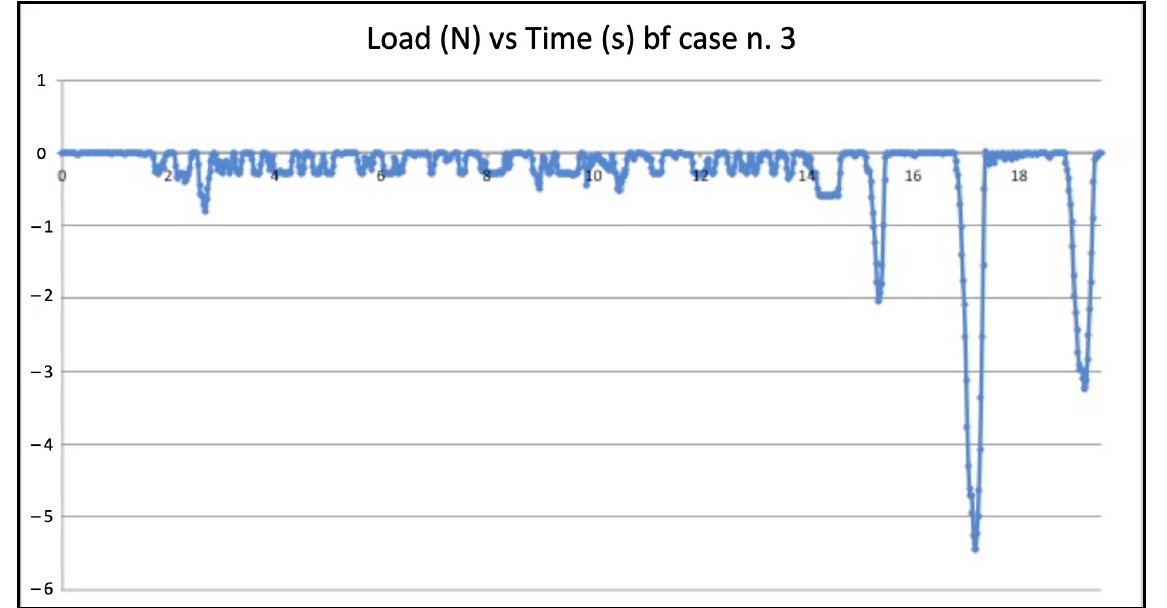
Figure 6. Graphic plot of the simulation on model n. 3 (successfully balanced force technique negotiation). Seven failed negotiations occurred in Group B (tooth n. 2, n. 5, n. 9, n. 14, n. 20, n. 22, n. 25). Figures 7 and 8 show the graphic plots of the simulation on model n. 26 and n. 7 (successful EOM negotiations), while for Group C, Figure 9 shows the graphic plot of the simulation of model n. 29, the only failed case. On the y-axis load (newton, N), and on the x-axis time (seconds, S). For all groups, the deformed files were the ones involved in the failed negotiation, i.e., n. 5 for Group A, n. 7 for Group B, and n. 1 for Group C; we did not find any broken files.